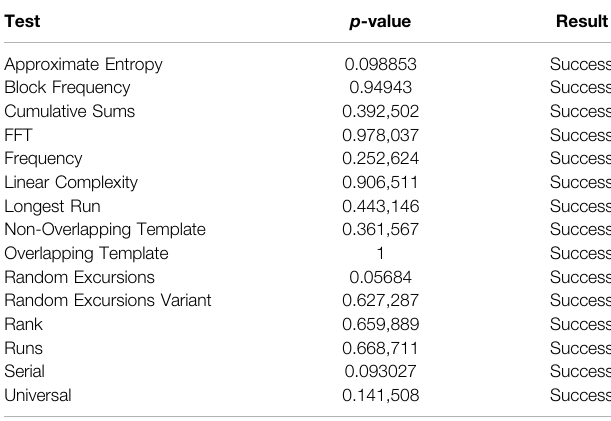
TABLE 6 | Results of SP 800 – 22 test using x 7 after decorrelation